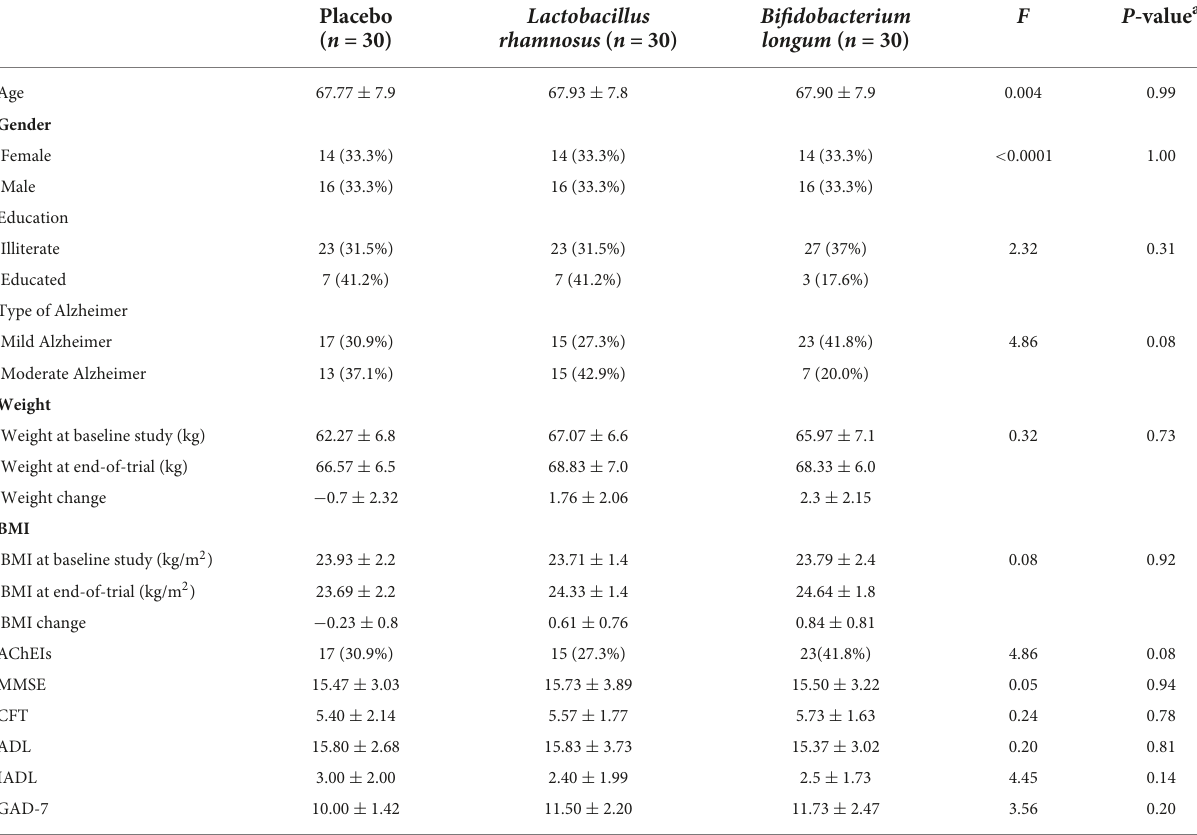
TABLE 1 Baseline characteristics of patients in the probiotic groups and the placebo group.*